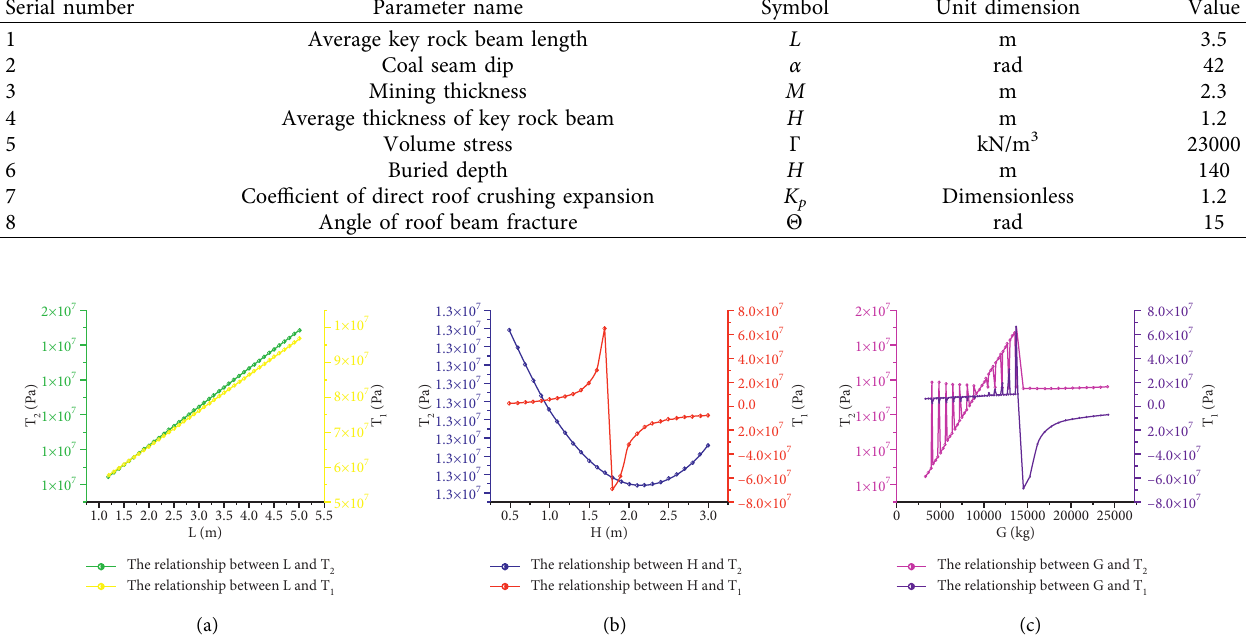
Table 1: Liu.Pan.Shui. coal mine measured geological data parameter table.